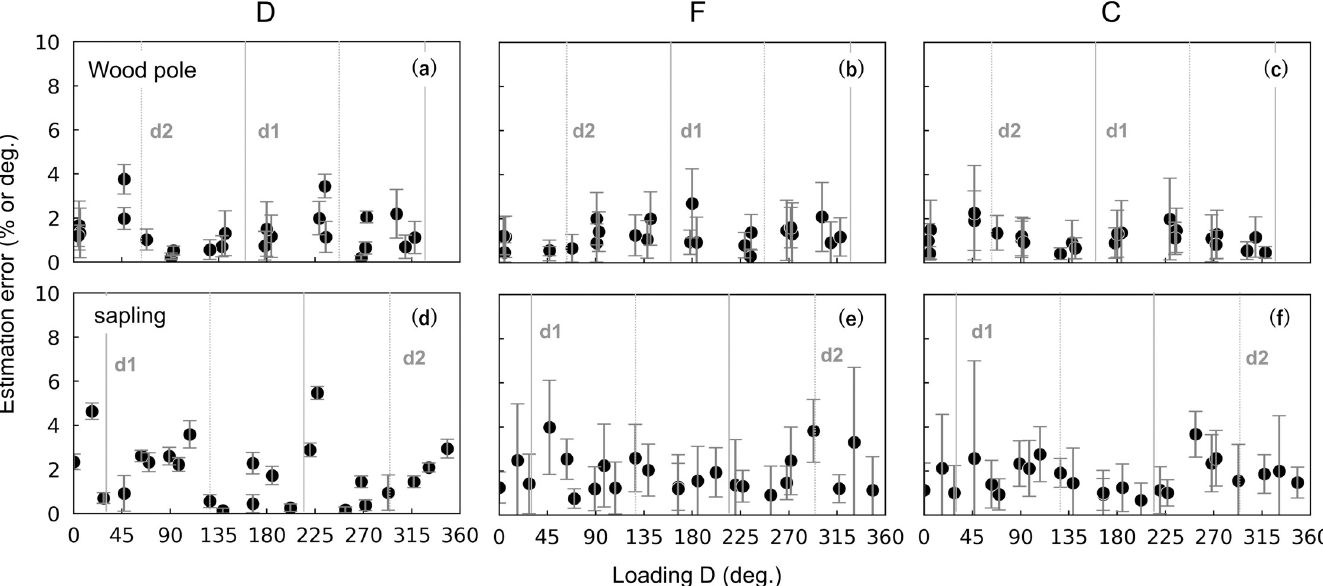
Fig 10. Estimation errors versus the known loading direction of force for the circumferential loading experiments. The estimation errors of (a, d) the direction of force at h t , D, (b, e) amount of force, F, and (c, f) the gravity center of force, C. Results for the wood pole (a–c) and sapling (d–f). Grey solid lines and ‘d1’ on the panel show the radial position and the radial position + 180˚ of d1 strain gauges; grey dotted lines and ‘d2’ show the radial position and the radial position + 180˚ of d2 strain gauges. For the calculation of the estimation errors, see the caption of Figs 5 and